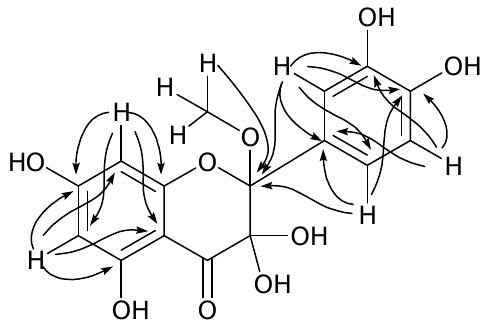
Figure 10. HMBC correlations observed for compound 45a